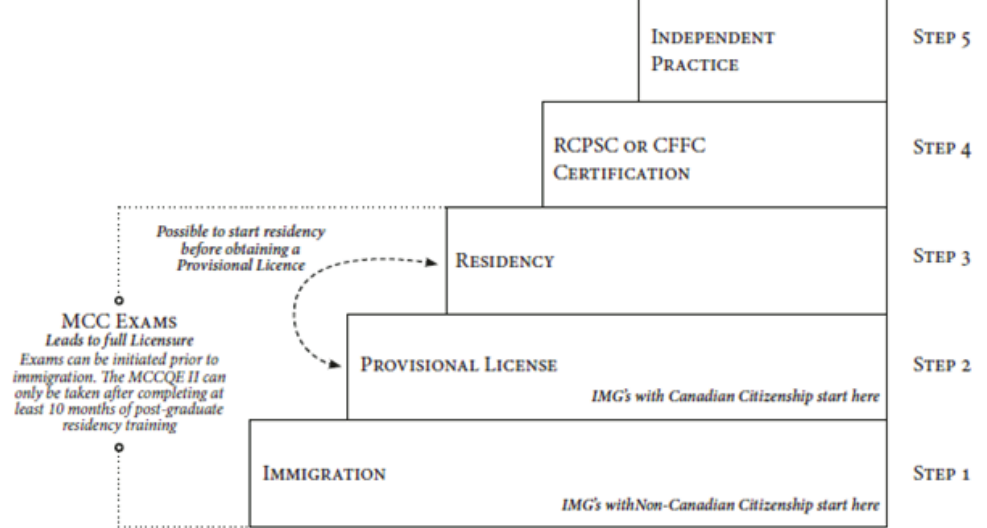
Figure 2. Five steps to independent